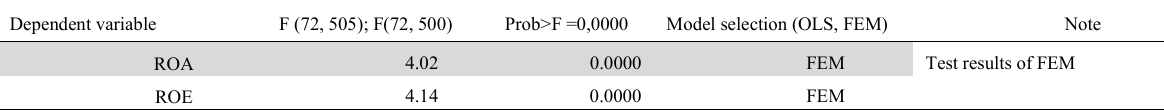
The test result between OLS and FEM